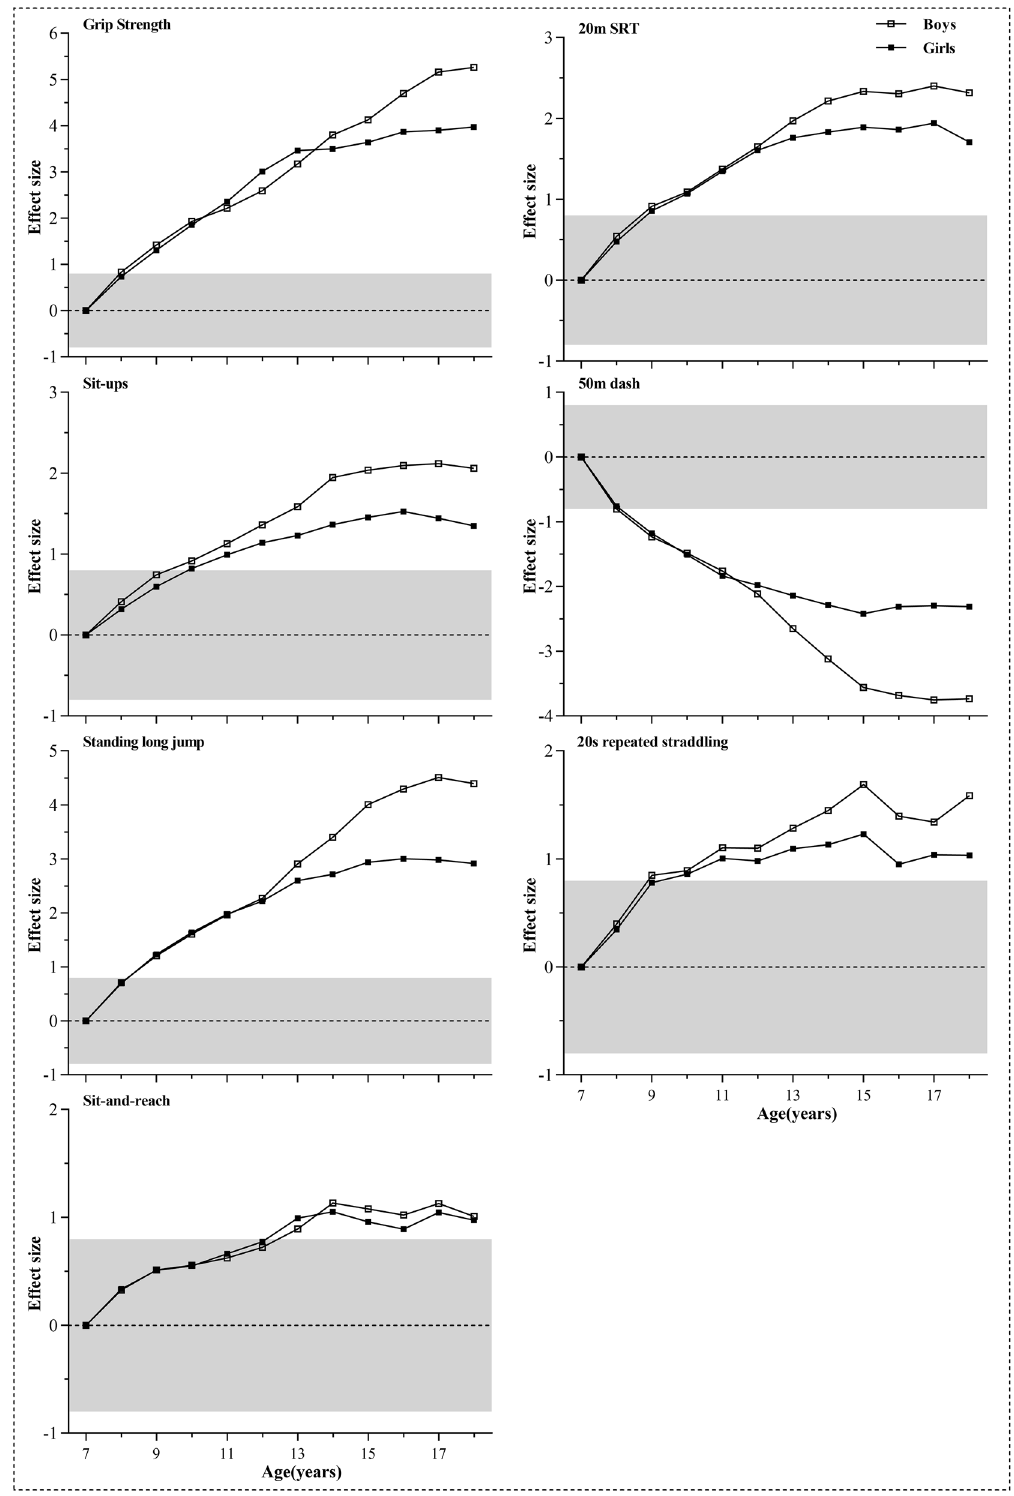
Figure 2. Age-related difference in each physical fitness test (( A ) grip strength, ( B ) 20-m SRT, ( C ) 30-s sit-ups, ( D ) 50-m dash, ( E ) standing long jump, ( F ) 20-s repeated straddling, ( G ) sit and reach) expressed as standardized effect sizes (anchored to age 7 years = 0). The limits of the grey zone represent the threshold for a large standardized difference (i.e., 0.8 or − 0.8). Positive effect sizes indicated that mean fitness test performances for older children and adolescents were higher than those for 7 years old